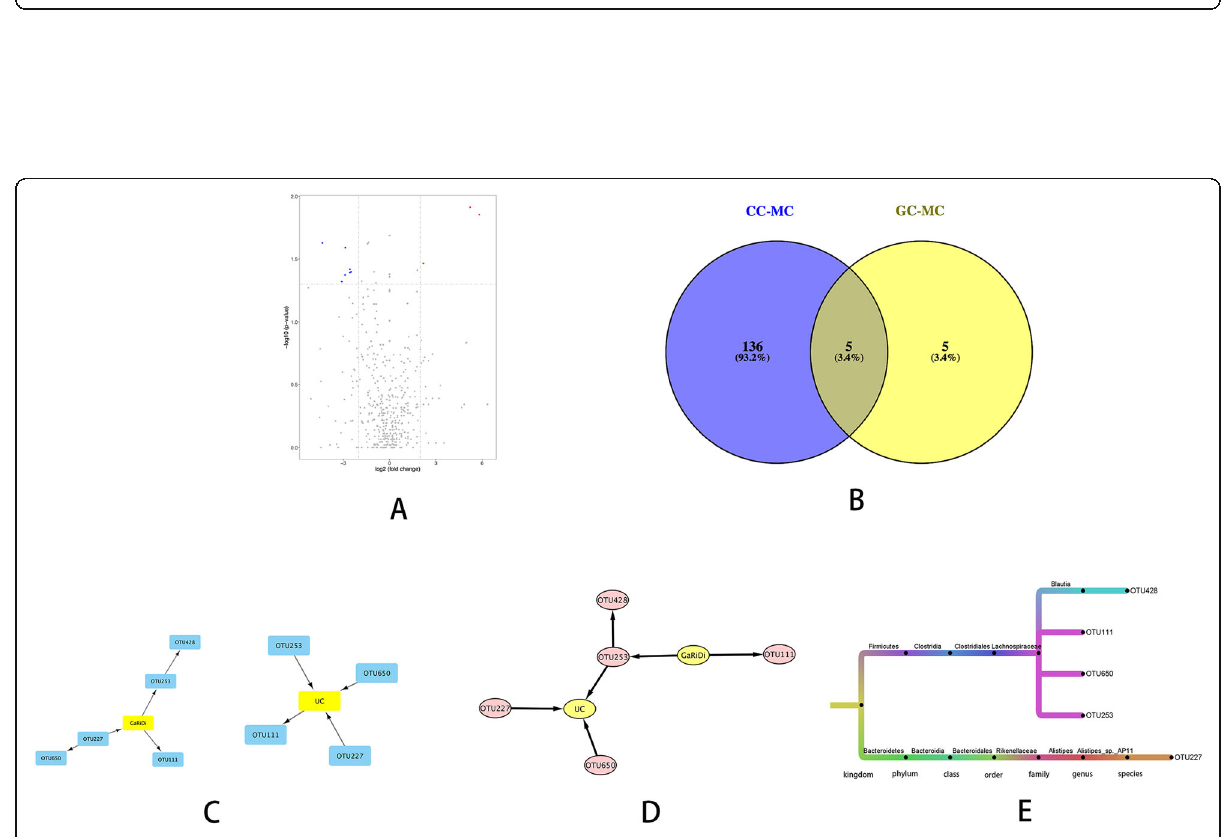
Fig. 3 Analysis of the differential microbial community among the groups. a Venn diagram of differential microbial communities among the control group, model group, and Garidisan-treated group. b Histogram of LDA value distribution of the differential microbial community among the control group, model group, and Garidisan group; c Cladogram of LDA values from the control group, the model group, and Garidisan group. *CC: the luminal content of the control group. MC: the luminal content of the model group. GC: the luminal content of the Garidisan group